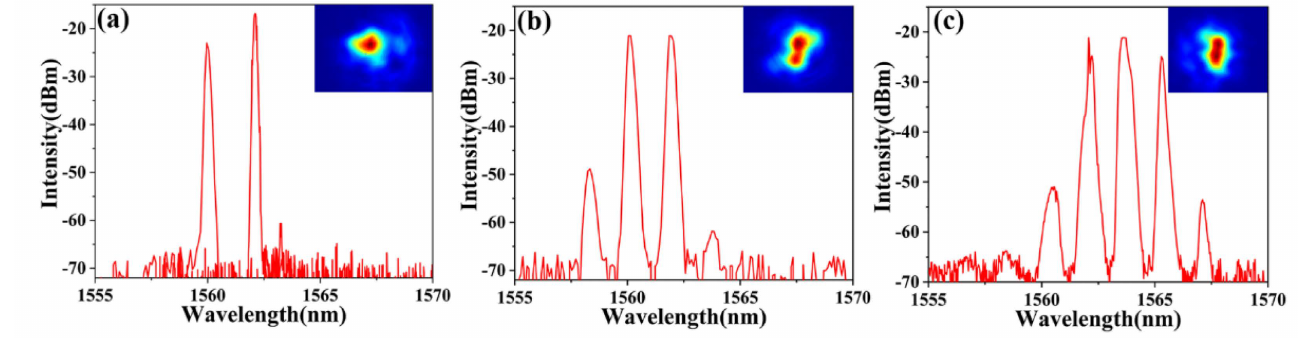
Figure 5. The multi-wavelength STML states: the mode-locked spectrum ( a ) dual-channels; ( b ) triple- channels; and ( c ) four-channels. Inset: beam